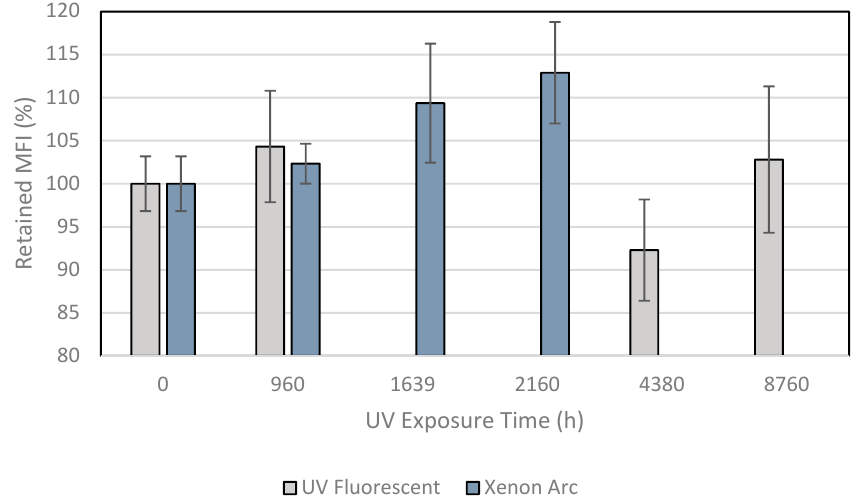
Figure 1. MFI test results showing behavior of the samples after UV exposures.